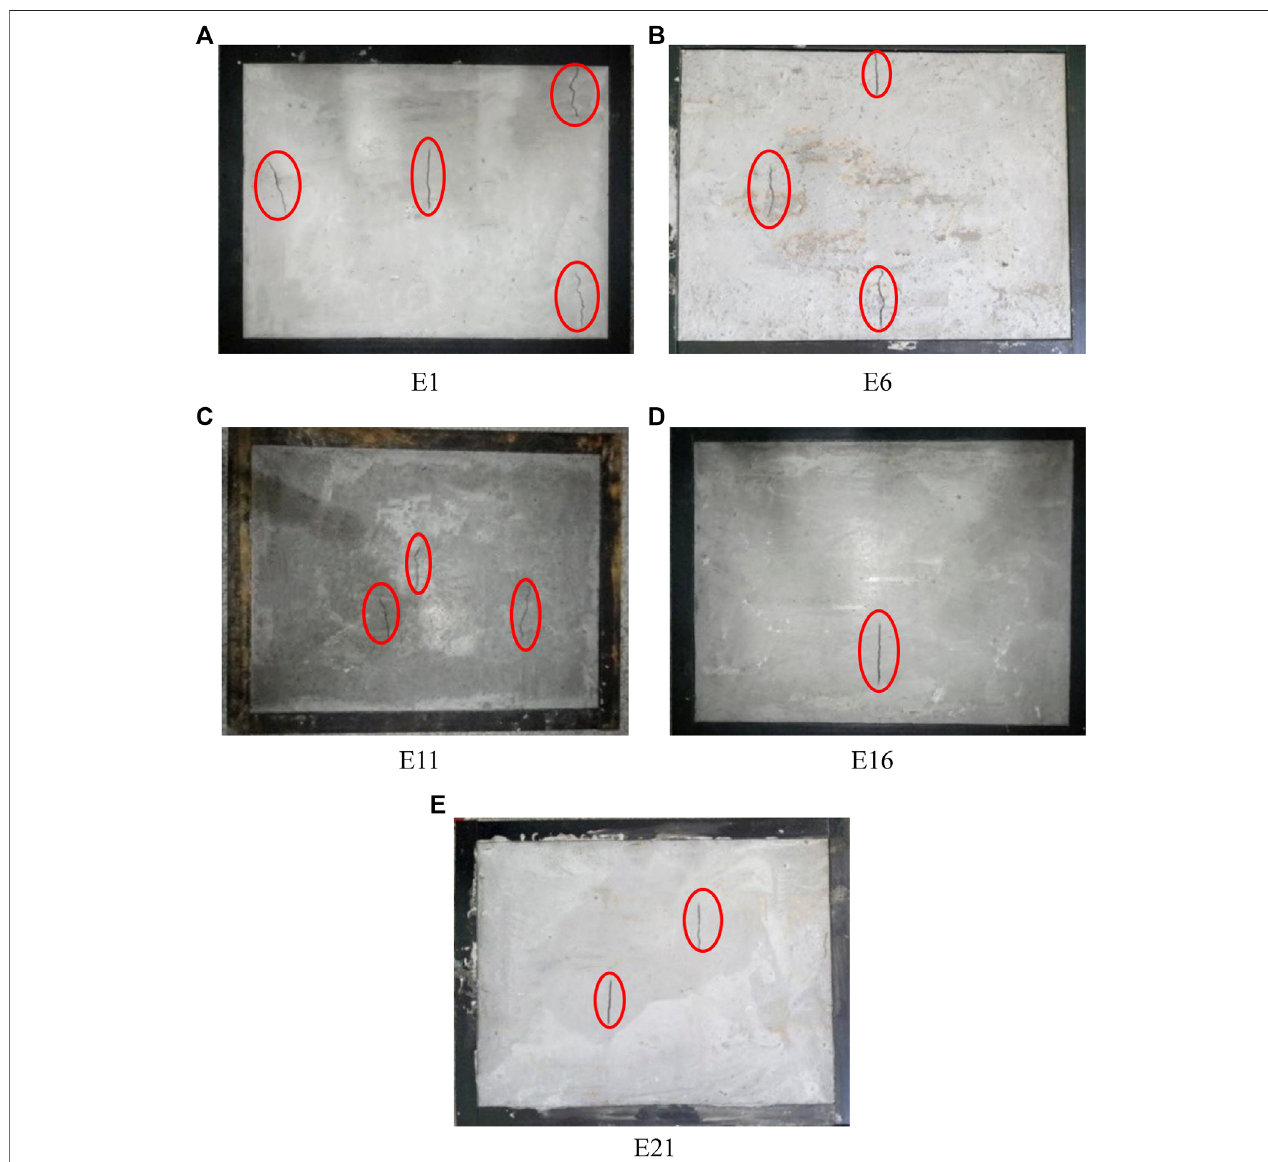
FIGURE 3 | Cracking state of concrete at the age of 3 days. (A) E1, (B) E6, (C) E11, (D) E16, (E) E21.